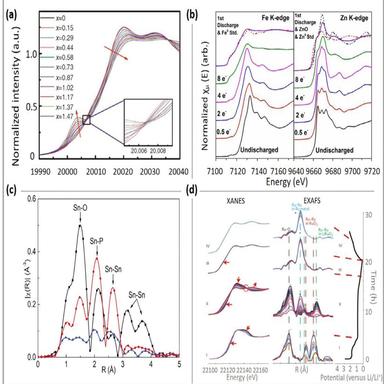
(a) In-situ XANES spectra of Mo K-edge during charging in a Li2MoO3/LiPF6/Li coin cell (Reproduced with permission from ref. Copyright 2014 Springer Nature); (b) Fe, Zn K-edges in different discharge states of ZnFe2O4 electrodes (Reproduced with permission from ref. Copyright 2017 American Chemical Society); (c) |v(R)| plots of Sn4P3/graphite electrodes from in-situ EXAFS (Reproduced with permission from ref. Copyright 2017 Wiley–VCH); (d) The in-situ XAS analysis